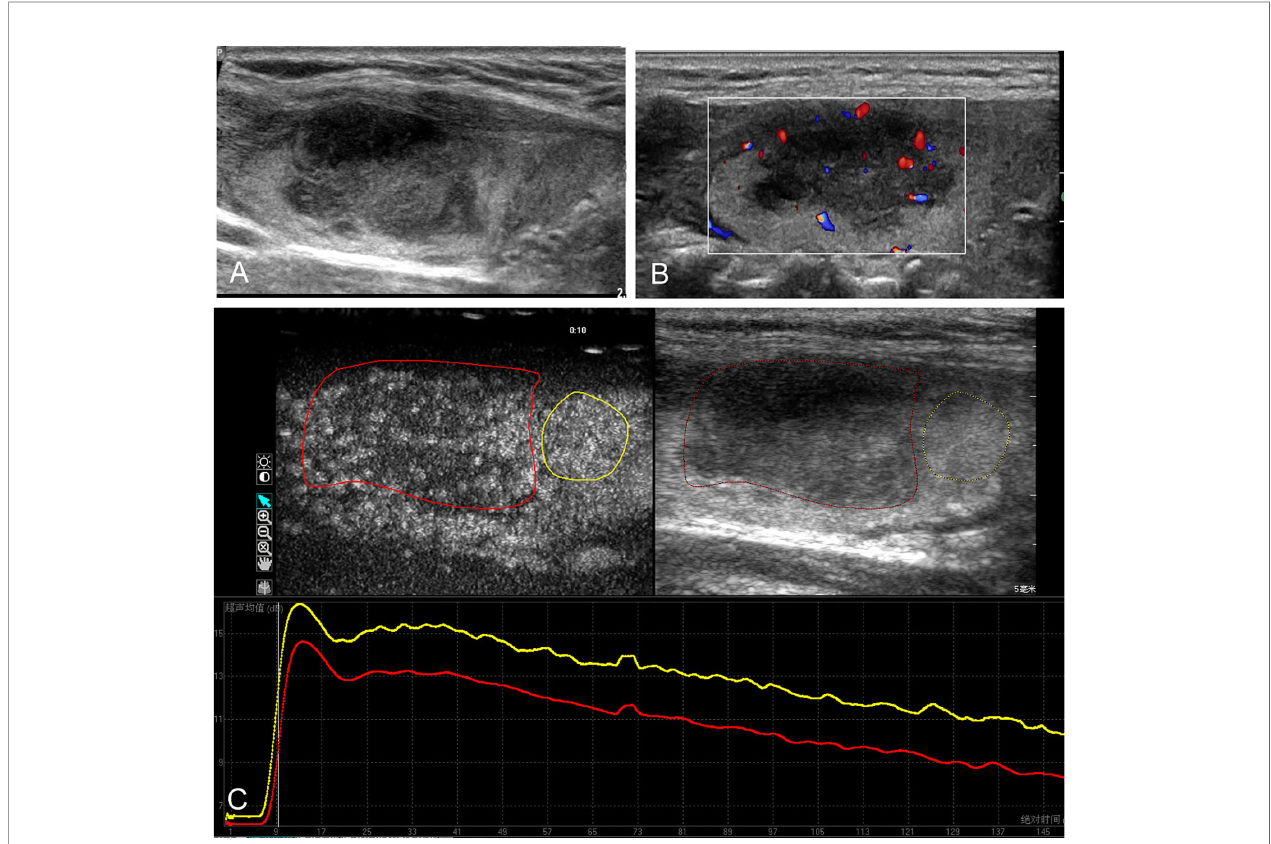
FIGURE 1 | Conventional ultrasound and contrast-enhanced ultrasound images of the primary thyroid lymphoma in the right thyroid lobe of a 67-year-old female with Hashimoto ’ s thyroiditis background. (A) B-mode ultrasound image of a maximum diameter of 28 mm nodule displayed hypoechogenicity with ill-de fi ned margin. (B) Color Doppler image revealing the internal and peripheral mixed distributed vascularity of the nodule. (C) Contrast-enhanced ultrasound image revealing the heterogeneous hypo-enhancement of the lesion (red circle), with respect to the surrounding parenchyma (yellow circle); time – intensity curves of the lesion (red line) and parenchyma (yellow line) were generated to calculate the corresponding quantitative